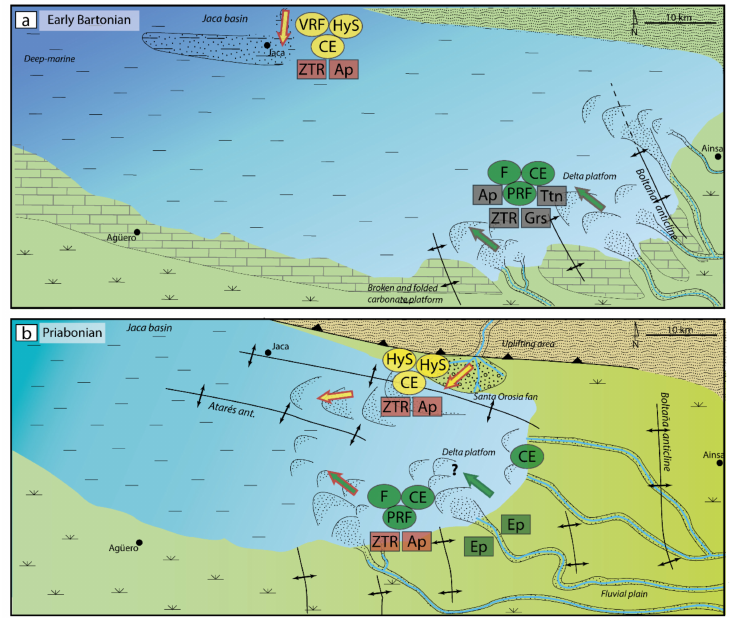
Figure 9. Paleogeographic scheme of the Jaca basin during Bartonian–Priabonian times. ( a ) Early Bartonian. ( b ) Priabonian. Circles and squares highlight distinct components. PRF: plutonic rock frag- ments, F: feldspar grains, CE: carbonate extrabasinal grains, HyS: hybrid sandstone rock fragments, VRF: volcanic rock fragments, Ap: apatite, ZTR: ZTR, Ep: epidote, Grs: grossular, Ttn: titanite. Circle colors correspond to petrofacies described in Figure 4. Square colors correspond to heavy-mineral suites described in Figure 7. Arrows indicate petrofacies (fill) and heavy-mineral suite (stroke). Reconstruction of the maps based on Puigdef à bregas, Bentham et al., Hogan, Montes, Caja et al., Huyghe et al., Roig é et al., Boya, Coll et al.